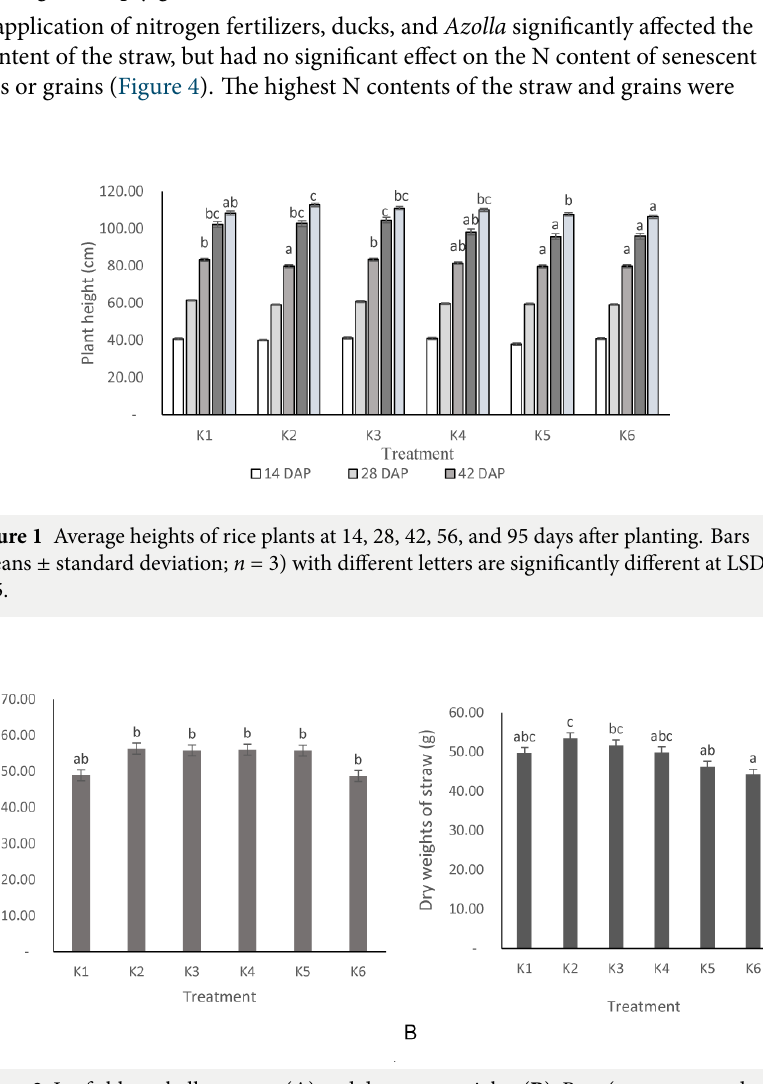
Figure 2 Leaf chlorophyll contents ( A ) and dry straw weights ( B ). Bars (means (cid:6) standard deviation; n = 3) with different letters are significantly different at LSD